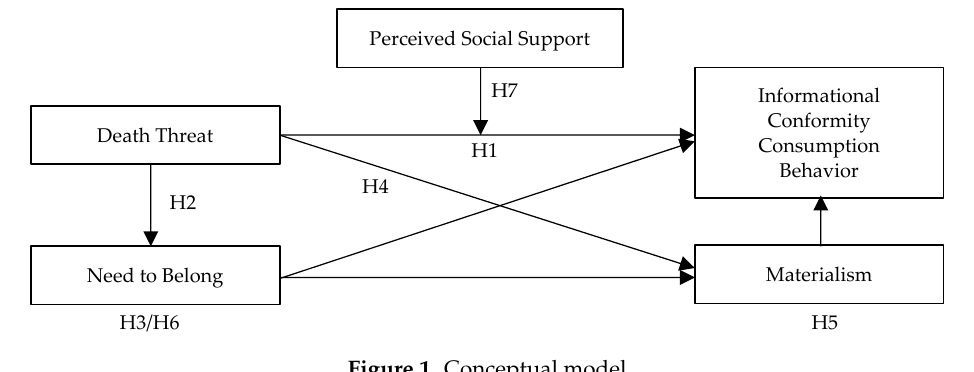
Figure 1. Conceptual model.